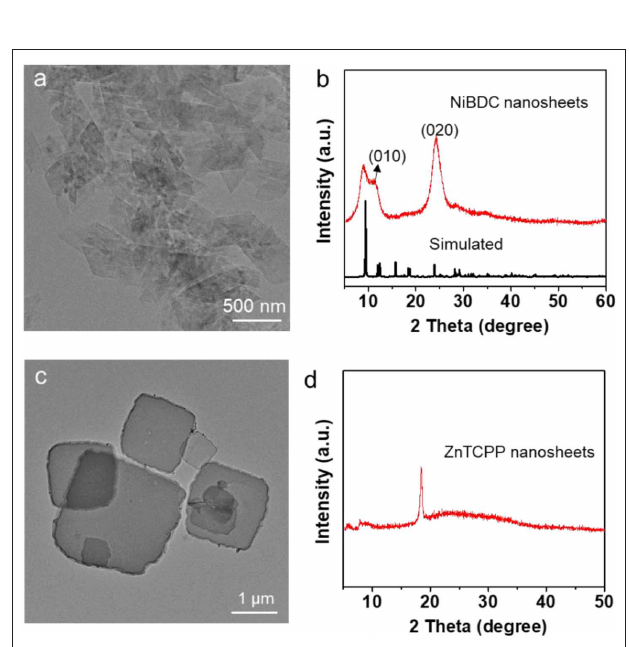
FIGURE 4 | TEM image (a,c) and XRD pattern (b,d) of NiBDC (a,b) and ZnTCPP (c,d) nanosheets.